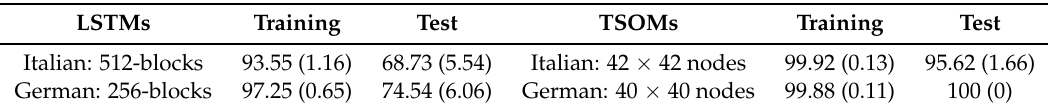
Table 2. Accuracy values for each language, neural network and training protocol. Standard deviations are given in